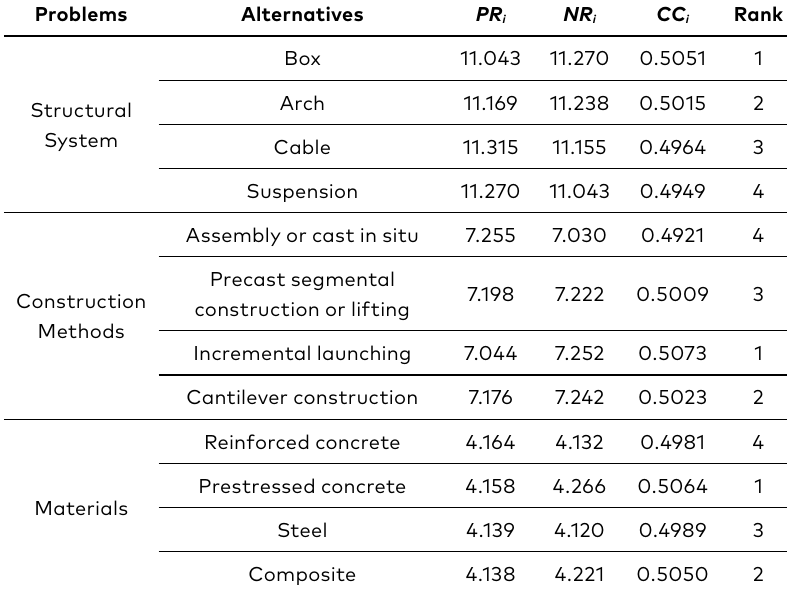
Table 9. The deviation ratios, the closeness